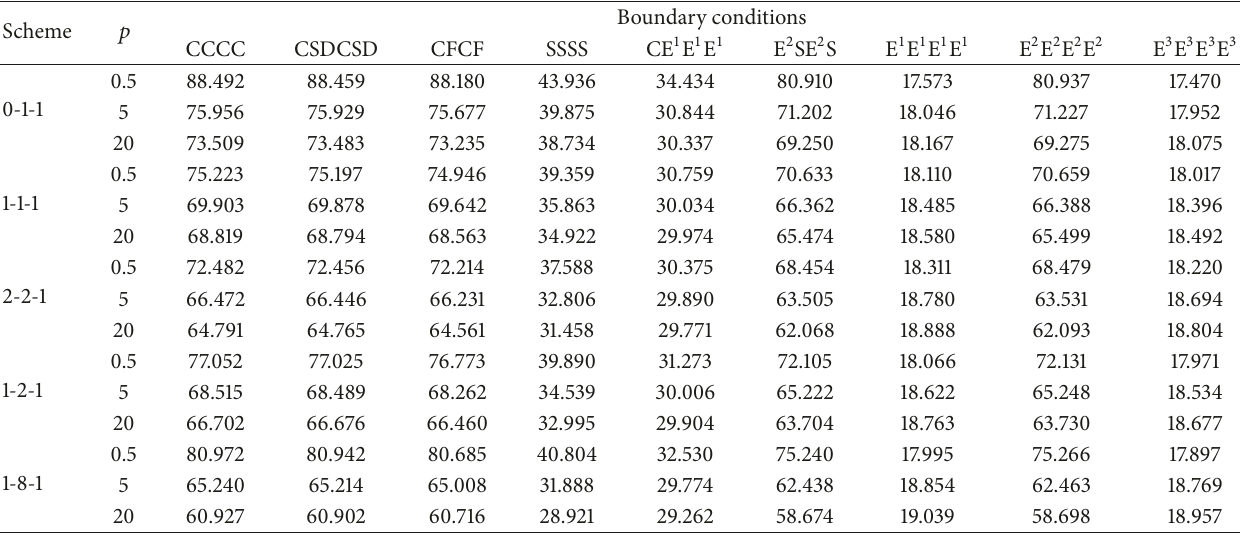
Table 8: Fundamental frequency parameter Ω for Type 2-2 annular sector plate with various boundary conditions ( 𝑅 0 /𝑅 1 = 0.5 , ℎ/𝑅 1 = 0.2, 𝑝 1 = 𝑝 3 = 𝑝 , and 𝜙 = 350 ∘ ). Scheme